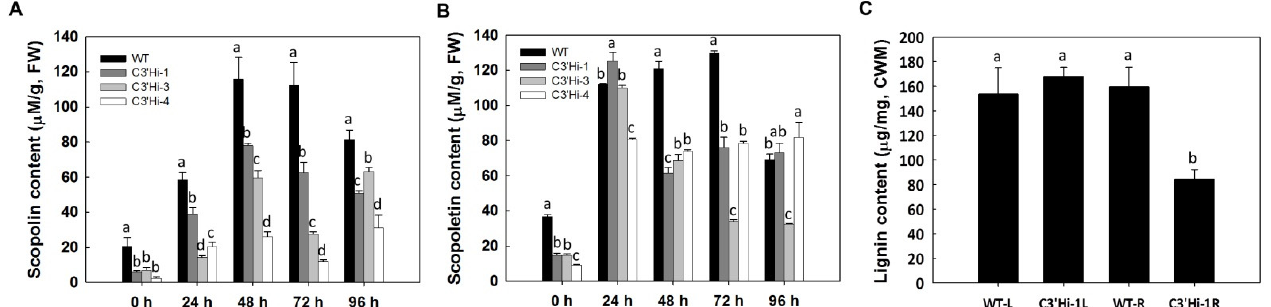
Figure 6. Analysis of secondary metabolite contents in SRs of transgenic plants and WT during the PPD process. ( A ) Scopoletin contents. ( B ) Scopolin contents. ( C ) The lignin content in leaves and SRs of WT and C3 ′ Hi-1. The plants were grown in the field for 5 months, and the mature leaves and storage roots were collected for lignin analysis. FW: fresh weight; CWM: cell wall material; L: mature leaf from the fifth to seventh apical position; R: storage root. Values labeled with different letters (a, b, c and d) at the same time point are significantly different according to Duncan’s mul- tiple comparison tests at p < 0.05.